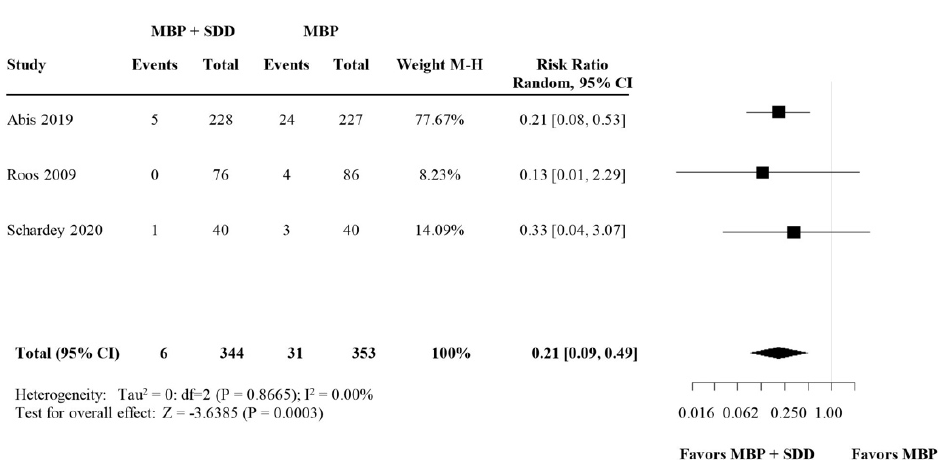
Figure 6. Forest plot comparing SSI rate for patients receiving SDD (selective decontamination of the digestive tract is selective OAB targeting only specific the aerobe, Gram-negative bacteria) in addition to MBP and i.v. antibiotic prophylaxis versus MBP with i.v. antibiotic prophylaxis. A random effects model was used to perform the meta-analysis and risk ratios are quoted including 95% confidence intervals.